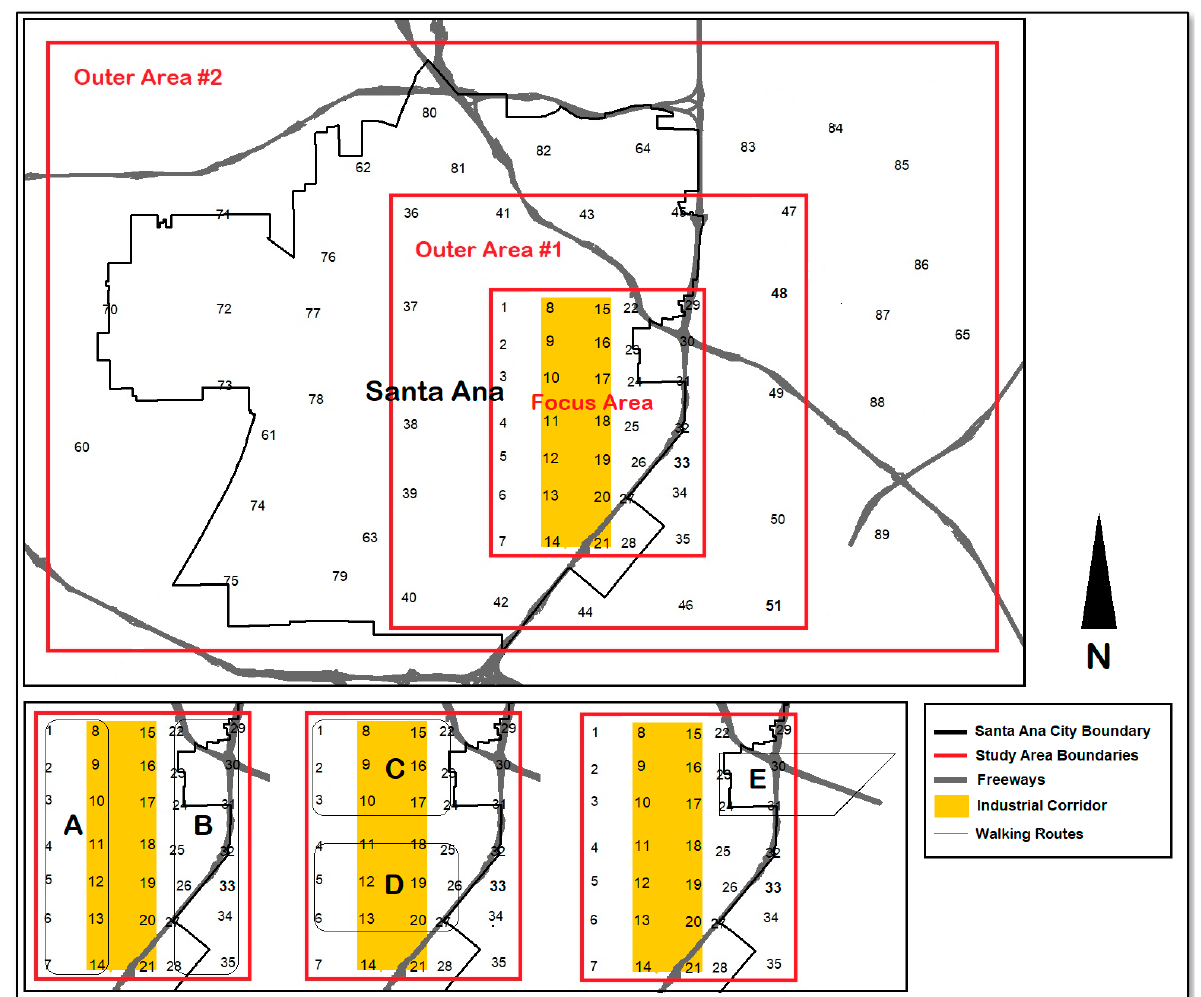
Figure 2. Map depicting regional sampling sites along with both the industrial corridor walking routes ( A – D ) and the freeway walking route ( E ).